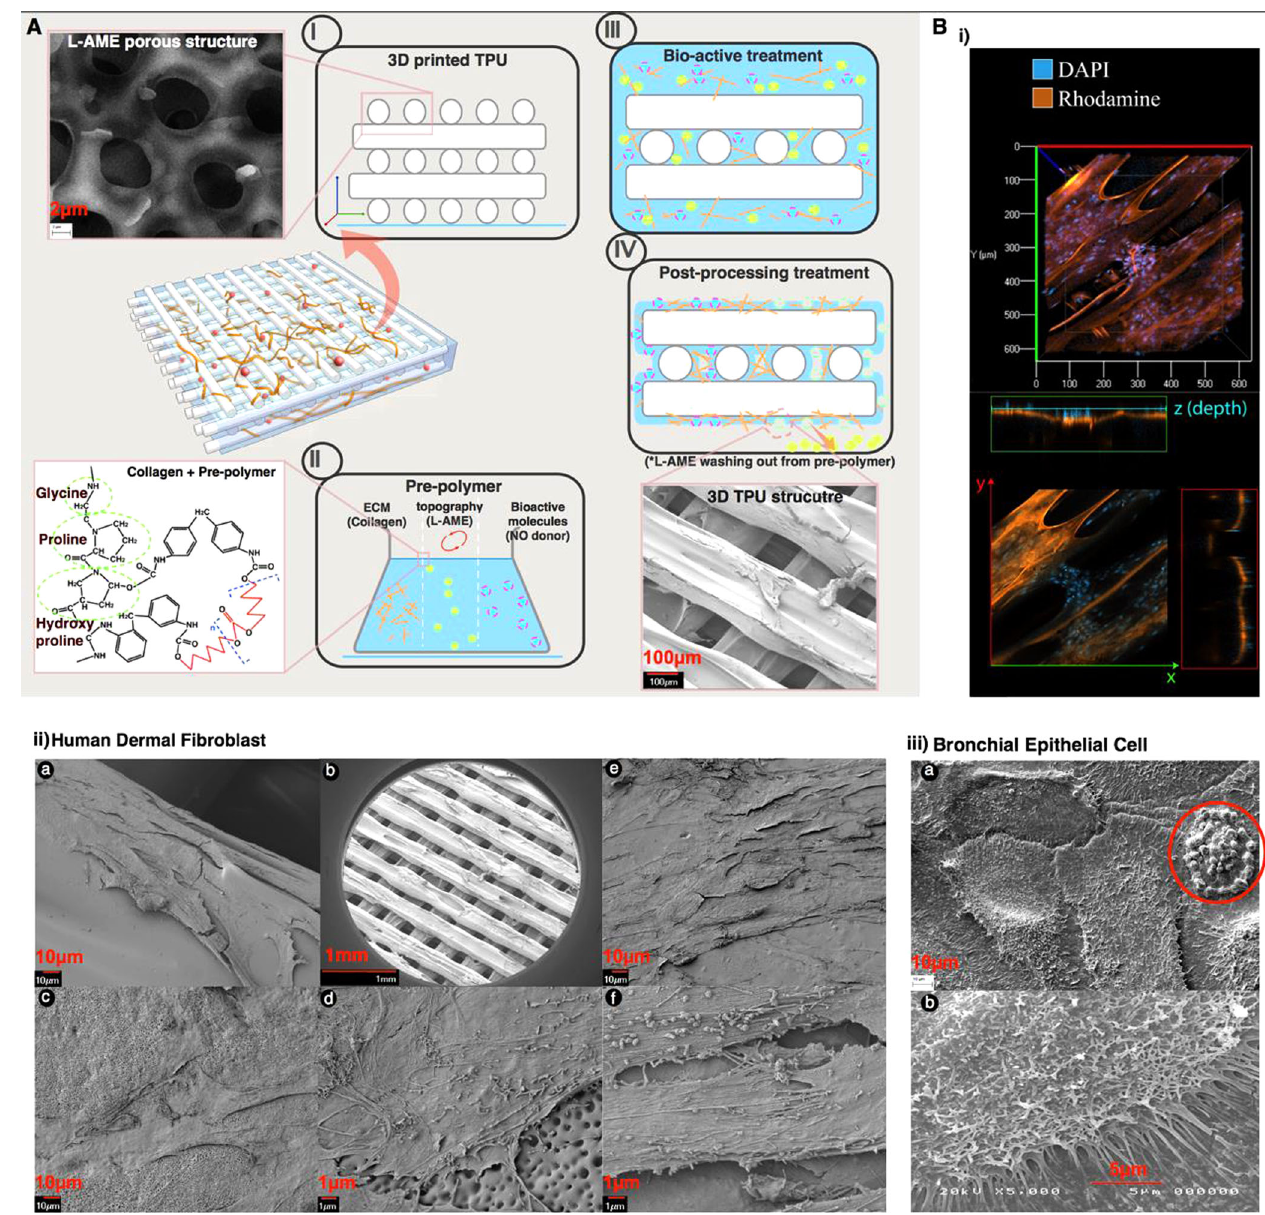
Fig. 2 Surface modi fi cation for biofunctionalisation; post processing of 3D printed scaffolds. a Diagrammatic illustration of post processing of 3D printed scaffold, with collagen as an example of ECM component, L-AME as example bioactive molecule, which were introduced with solution based pre-polymer acting as a ‘ glue ’ . Subpanels i-iv indicate the order in which post-processing of scaffolds can be carried out to obtain a biofunctionalised 3D printed scaffold. b Cell interactions on 3D printed scaffold surface (i) DAPI Fluorescence staining (Blue) demonstrating presence of cells on the scaffold (stained in red). SEM images. (ii) a , b . (higher mag). HDF at day 3 on 3D printed TPU90 surface. c , d . (higher mag) HDF at day 3 seeded on 3D printed TPU90 surface functionalised with L-AME. Red arrow indicating L-AME pores on the scaffold. e , f . (higher mag) HDFs at day 3 seeded on 3D printed TPU90 surface functionalised with collagen. (iii) BEC (at day 14) seeded as a submerged culture on 3D printed TPU80 surface biofunctionalised with collagen and L-AME. a. Mucus synthesis indicated within red circle . b. a cell prominent with